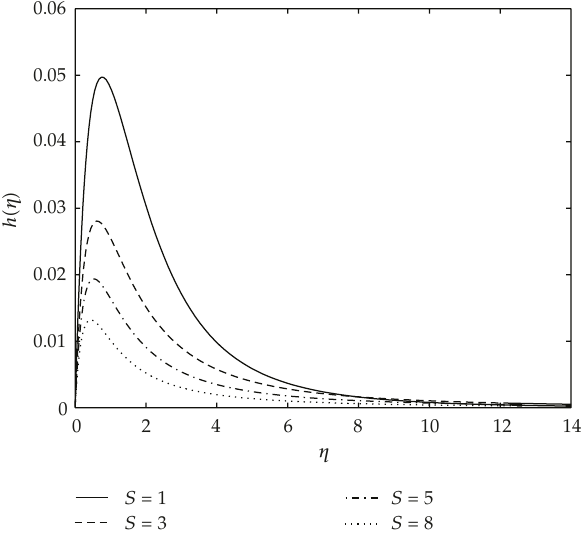
Figure 6: Transverse velocity profiles for various values of S with M (cid:5) 1, Pr (cid:5) 0 . 72, m (cid:5) 1, β 1 (cid:5) 0 . 1, and β 2 (cid:5) 0 . 1